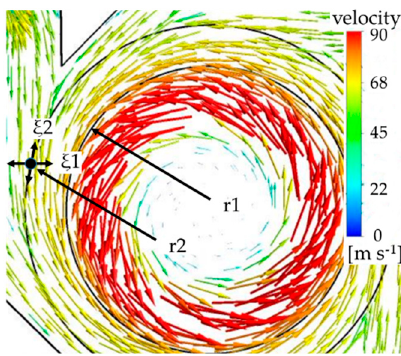
Figure 10. Mean flow field of combustion air in swirler at medium height of the swirler channel. Position ξ 1 marks a perpendicular orientation of the spray sheet to the airflow and position ξ 2 indicates an oscillation inline to the crossflow. Radii r1 and r2 indicate two different radial positions investigated.